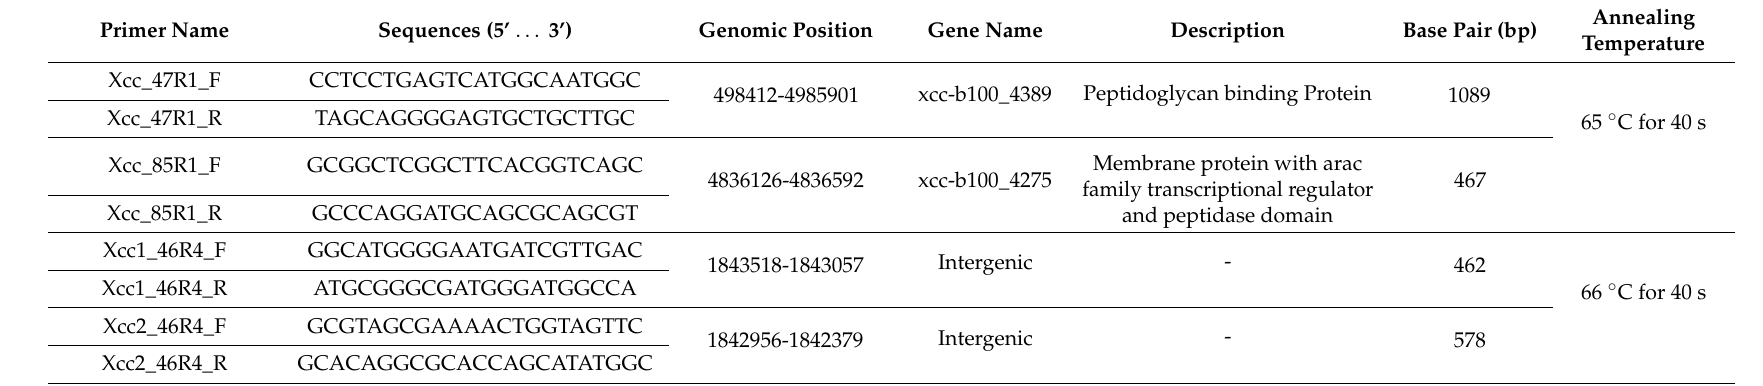
Table 3. Primer sets used for Xcc race 1 and race 4-specific PCR